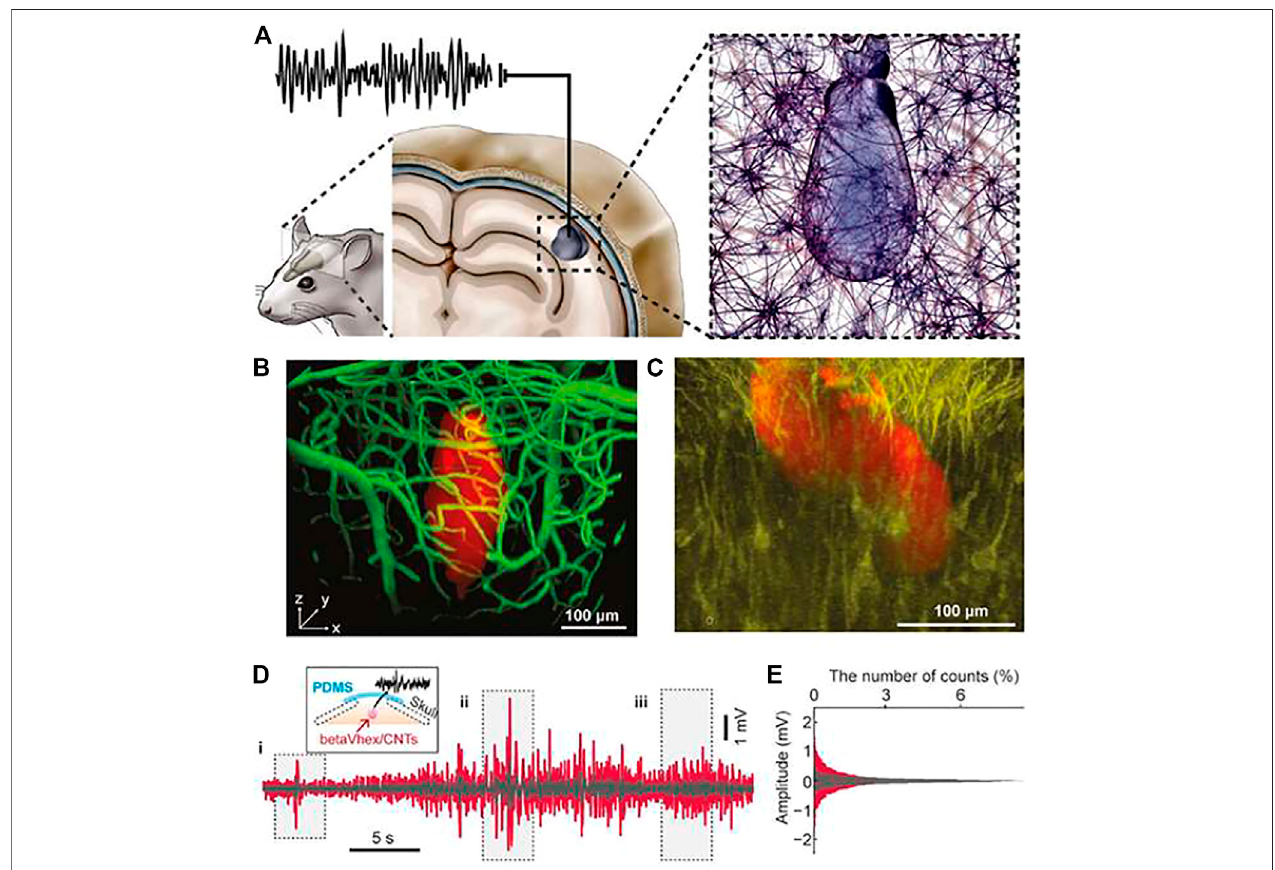
FIGURE 7 | Peptide hydrogel for neurone repair. (A) Schematic presentation of the hydrogel injected into the mouse brain cortex and interacting with neurons. (B) Image(sideview)ofCNT-peptidecompositehydrogelinjectedwithinthebraincortexandthebrainvasculaturevisualizedbyFITC-dextraninjection. (C) Image(sideview) ofneuronalstructure(Thy1-GCaMP6fmouse)andtheinjectedhydrogel. (D) LFP(local fi eldpotential)recording;red,LFPsignalsmeasuredwiththehydrogel;gray,those measured with bare electrodes inserted 1 mm apart. The inset fi gure is a schematic illustration of LFP measurements with the CNT-peptide composite hydrogels through the PDMS. (E) Distribution of the LFP signal amplitudes shown in (D) . Reproduced with permission (Nam et al., 2020). Copyright 2020 American Chemical